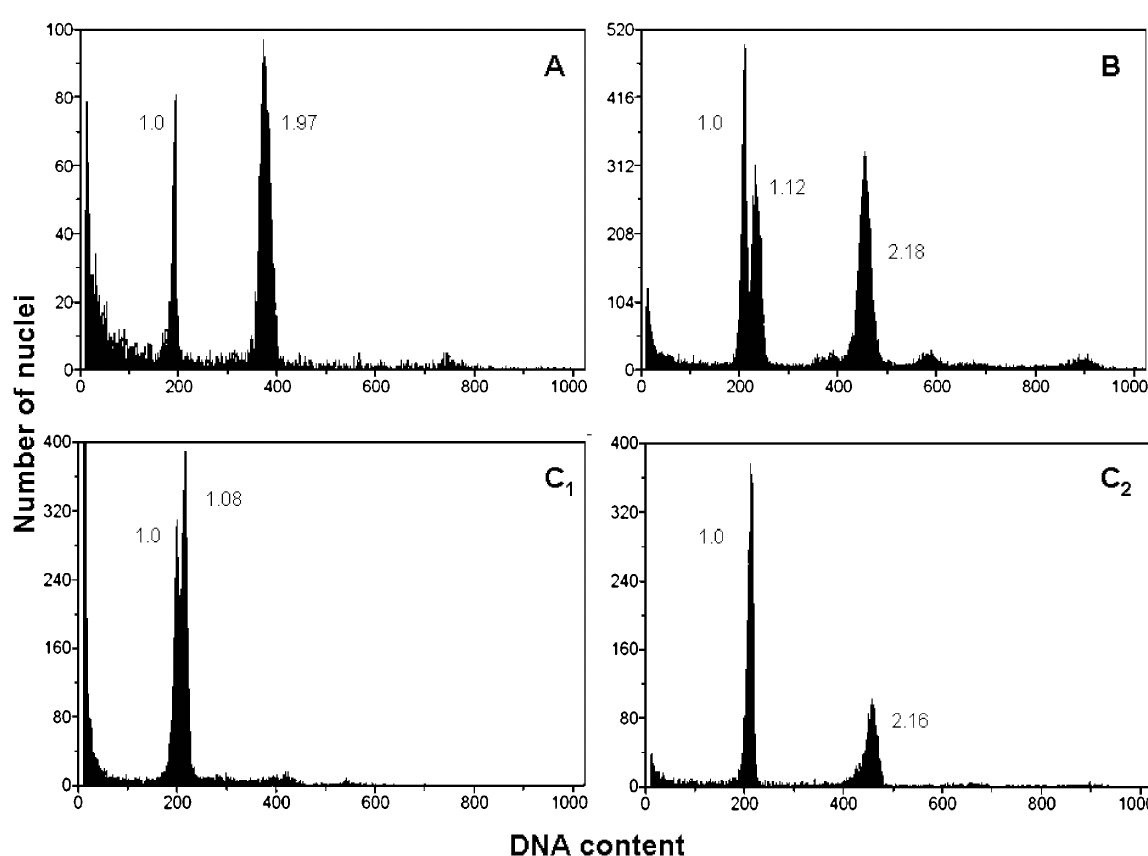
Fig. 2. Examples of “DNA endoreduplication”. (A) shows a diploid/near-diploid subline ( DI = 1 . 0) and a near-tetraploid subline with DI = 1 . 97. The diploid–tetraploid theory [42] proposes that a diploid cell in precursor lesions of solid tumors generates an early intermediate tetraploid state ( DI = 2 . 0) and a later cascade of DNA high aneuploid sublines with lower DI values by chromosomal loss. An alternative model proposes that an early event of the natural history of the tumor precursor lesions is the generation of near-diploid aneuploid cells/sublines, which may later “endoreduplicate” into unstable high aneuploid sublines [10]. This model is illustrated (B), where a subline with DI = 1 . 12 is shown to co-exist with a second one with about twice the near-diploid DI value ( DI = 2 . 18). An additional example, in which a subline with DI = 1 . 08 “endoreduplicated” into a second one with DI = 2 . 16, is reported in the panels C 1 and C 2 (C 1 and C 2 histograms were obtained from two separate samples from the same oral lesion; see also